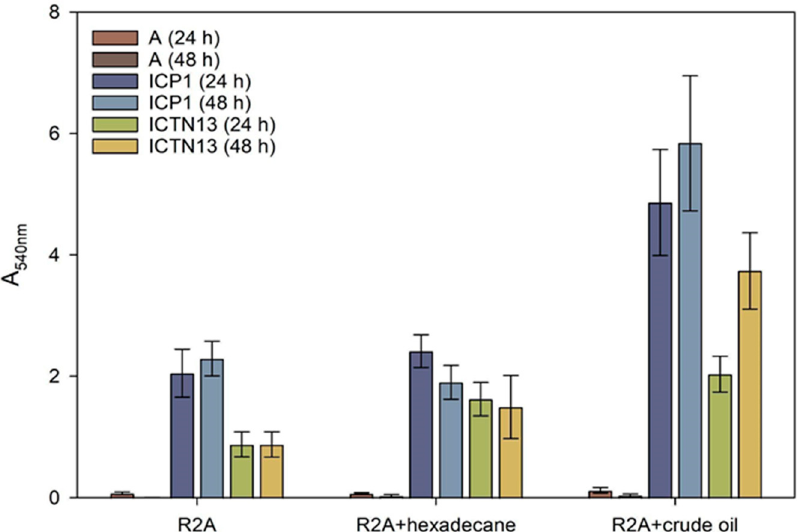
Figure 9. Biofilm formation on test tubes by the strains A. venetianus ICP1 and P. oleovorans ICTN13 in R2A medium and R2A medium supplemented with hexadecane or crude oil (final concentration 1%) after 24 h and 48 h incubation. Biofilm formation was measured as the absorbance at 540 nm (A 540 ) of the crystal violet solution rinsed from the cells that had adhered to the walls of test tubes. The abiotic controls (without cells, designated with A) were included to show the medium’s effect in binding the stain. Error bars indicate the standard deviation of the three independent biological experiments.